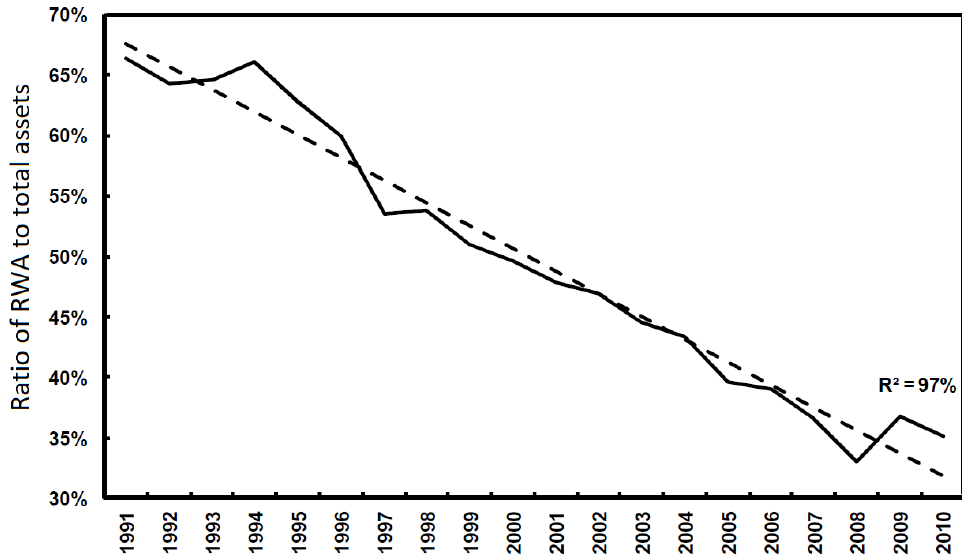
Figure 1. Ratio of risk-weighted to total assets for systemically important banks. Source: Reproduced with permission from Slovik (2012, p.